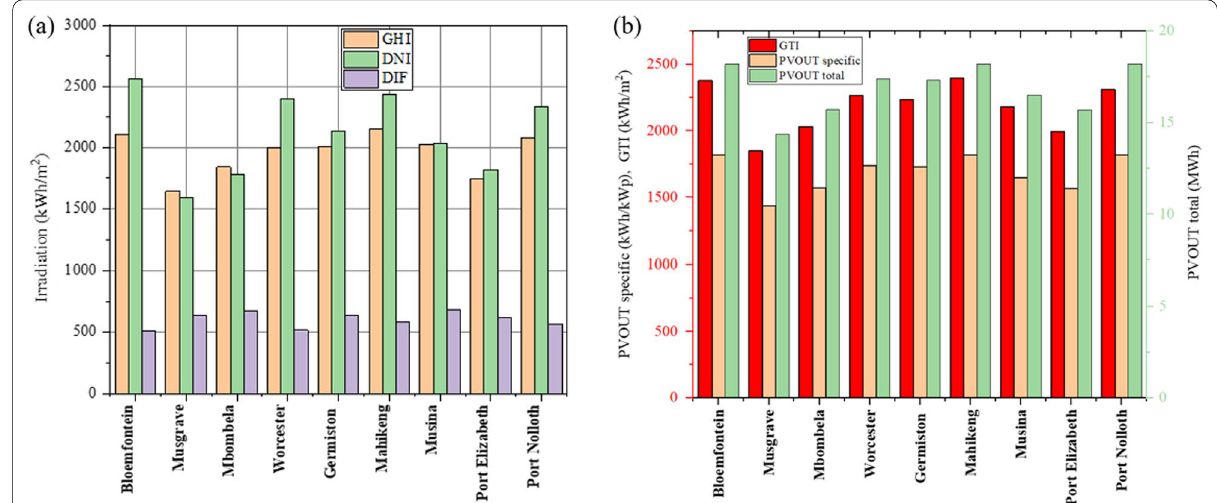
Fig. 7 Profile of yearly a insolation; b PV power output and GTI of the different site locations in South